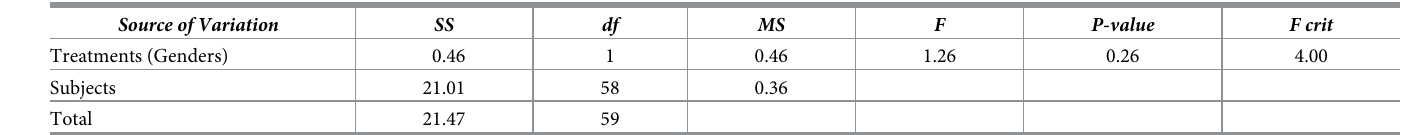
Table 16. One-way ANOVA—Viewpoint #4.